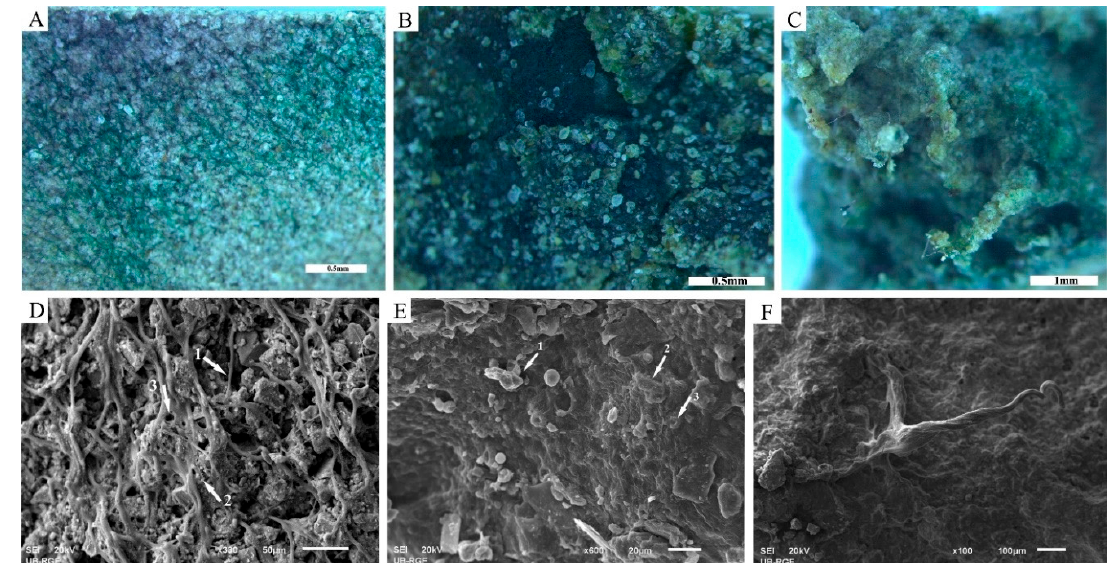
Figure 8. Trapping of particles. Three types of particle trapping were observed: net-like trapping ( A , D ), carpet-like trapping ( B , E ) and trapping by pinnacles ( C , F ). Cyanobacterial network connected the particles ( D , arrow 1), trapped fine particles on the exopolysaccharides (EPSs) surface ( D , arrow 2) and made pores ( D , arrow 3). Dense, carpet-like, cyanobacterial cover ( E , arrow 3) adhered particles onto the surface of polysaccharide matrix ( E , arrow 1) and grew over the overlapping particles ( E , arrow 2).